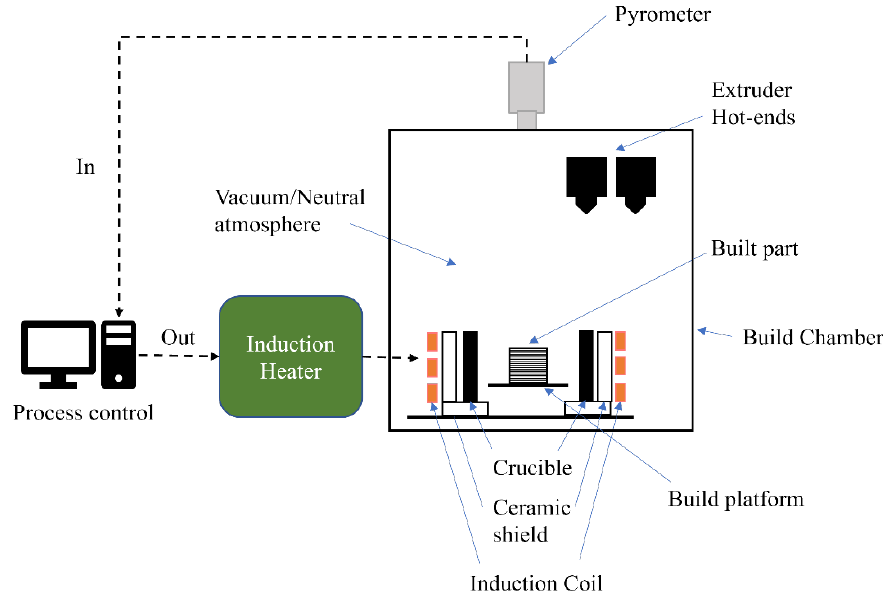
Figure 2. Illustration of the hybrid FFF and indirect induction sintering enabling in situ processing.